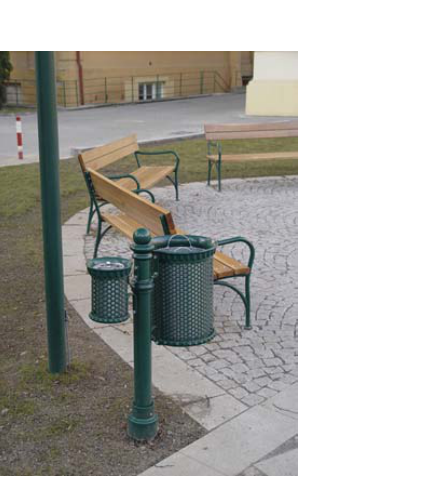
Figure 10 – Anchoring a wastebasket in a square – a discreet barrier Рис . 10 – Крепеж урны для мусора в сквере – неброское препятствие Слика 10 – Причвршћене корпе за отпатке на тргу – неупадљива